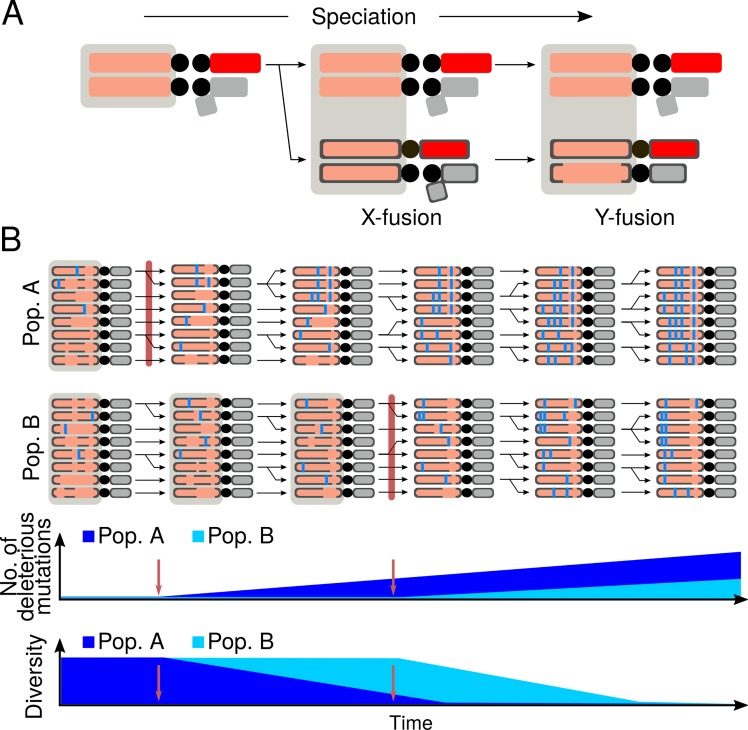
Multi-step model for neo-Y evolution in D. albomicans.A. The sequential fusions of the neo-sex chromosomes during speciation are depicted in the schematic. D. albomicans chromosomes have black outlines, to differentiate from D. nasuta chromosomes. Chromosomes that can recombine with each other are encompassed by gray boxes. Following the neo-X fusion, the neo-Y emerged via fusion with a chromosome that harbors a block of D. nasuta haplotype (no black outlines). B. Prior to the cessation of male recombination, the diversity of neo-Y is primarily the product of recombination with the neo-X and Chr. 3. During this time, the D. nasuta haplotype on the neo-Y is broken down by recombination with the neo-X. After males stop recombining in the population (maroon bar), the diversity is rapidly lost leading to the fixation of different haplotypes in different populations and deleterious mutations (blue bars) begin to accumulate on the neo-Y. The population in which male recombination stopped earlier (Pop. A) is expected to have more degenerate neo-Ys as compared to the population in which recombination stopped later (Pop. B). Bottom graphs track the accumulation of deleterious mutations and reduction in diversity in the two populations over time. Cessation of male recombination in the two populations are marked by red arrows.